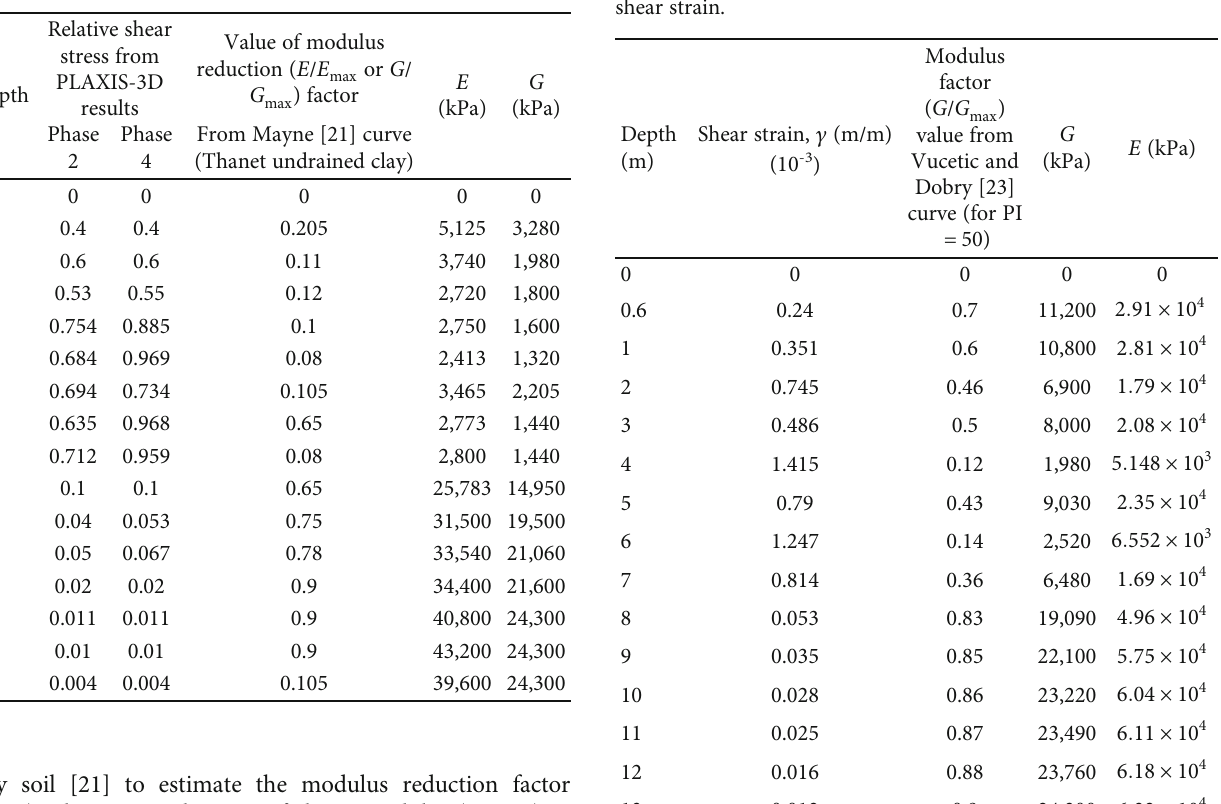
Table 7: Calculation of modulus reduction factor and corresponding elastic modulus ( E ) and shear modulus ( G ).